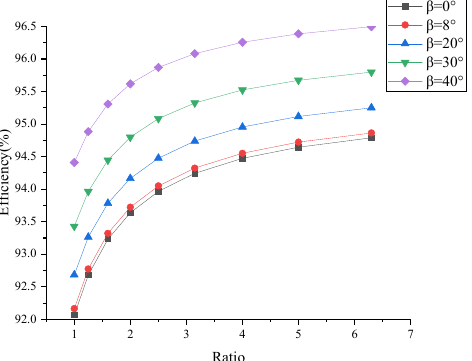
Figure 5. Gear efficiency versus gear ratio for non-lubricated gears.